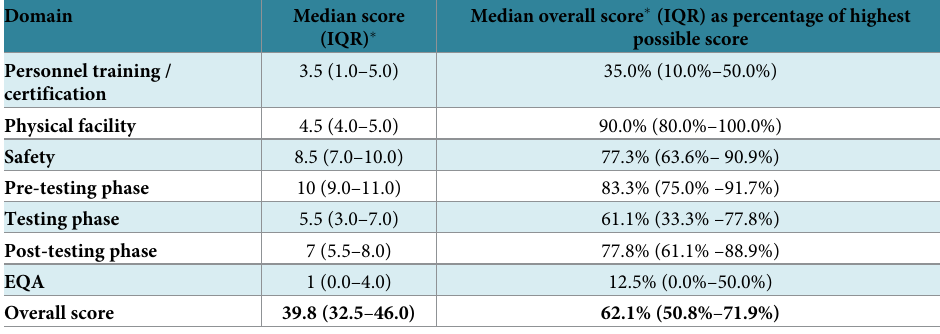
Table 1. Median scores and percentages by domain: Quality of HIV rapid testing practices, South